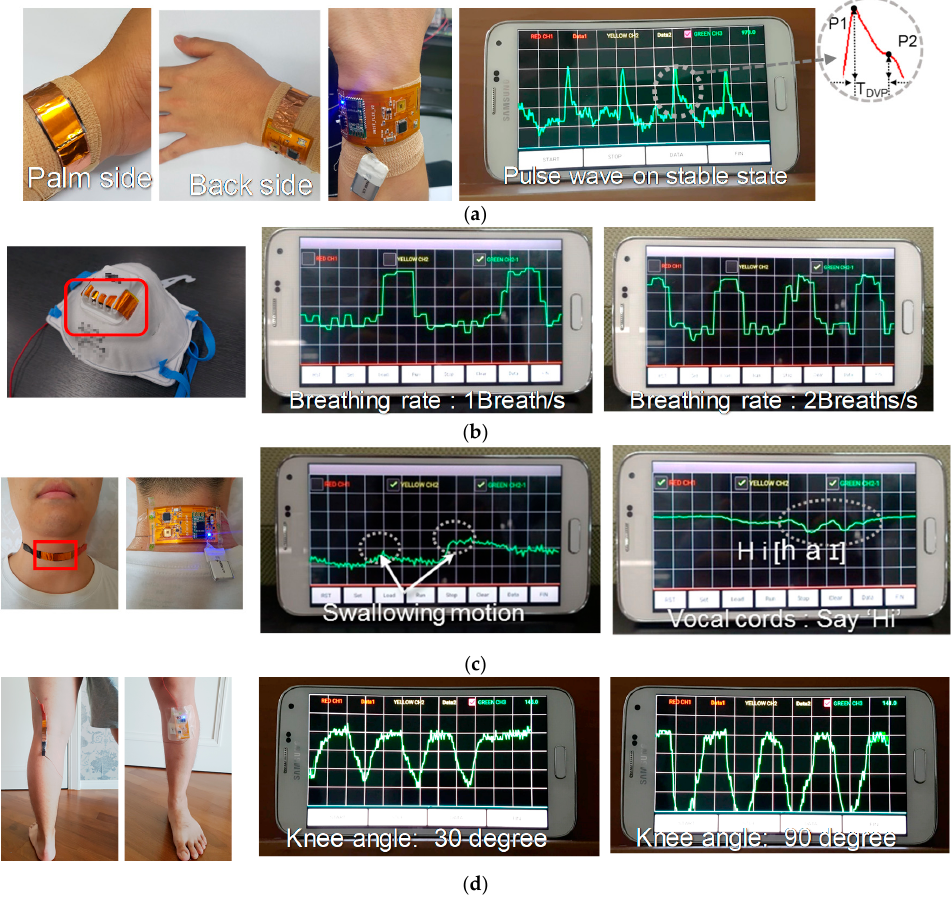
Figure 7. Experimental results of P-mode e-skin sensor interface: ( a ) pulse wave; ( b ) breathing; ( c ) swallowing and movement of vocal cords; ( d ) knee angle.